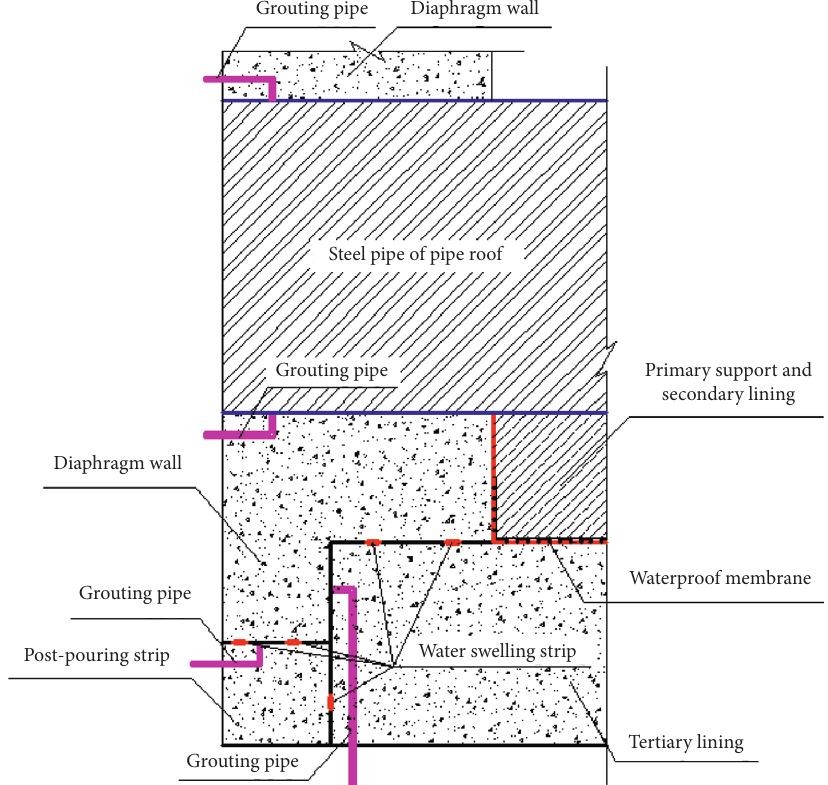
Figure 11: Waterproof schematic diagram of the connection between the tunnel excavation section and the shafts.